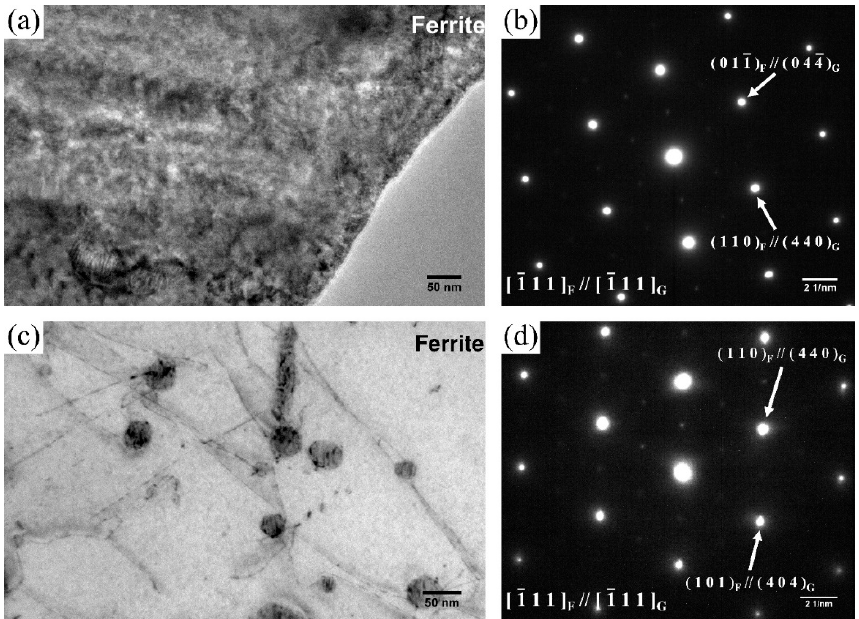
Figure 3. TEM results of Z3CN20.09M. ( a ) Aged at 475 °C for 2000 h and (c) aged at 475 °C for 2000 h then annealed at 550 °C for 3 h. ( b ) and ( d ) are the corresponding electron diffraction ( ED) pattern of ( a ) and ( c ), respectively.